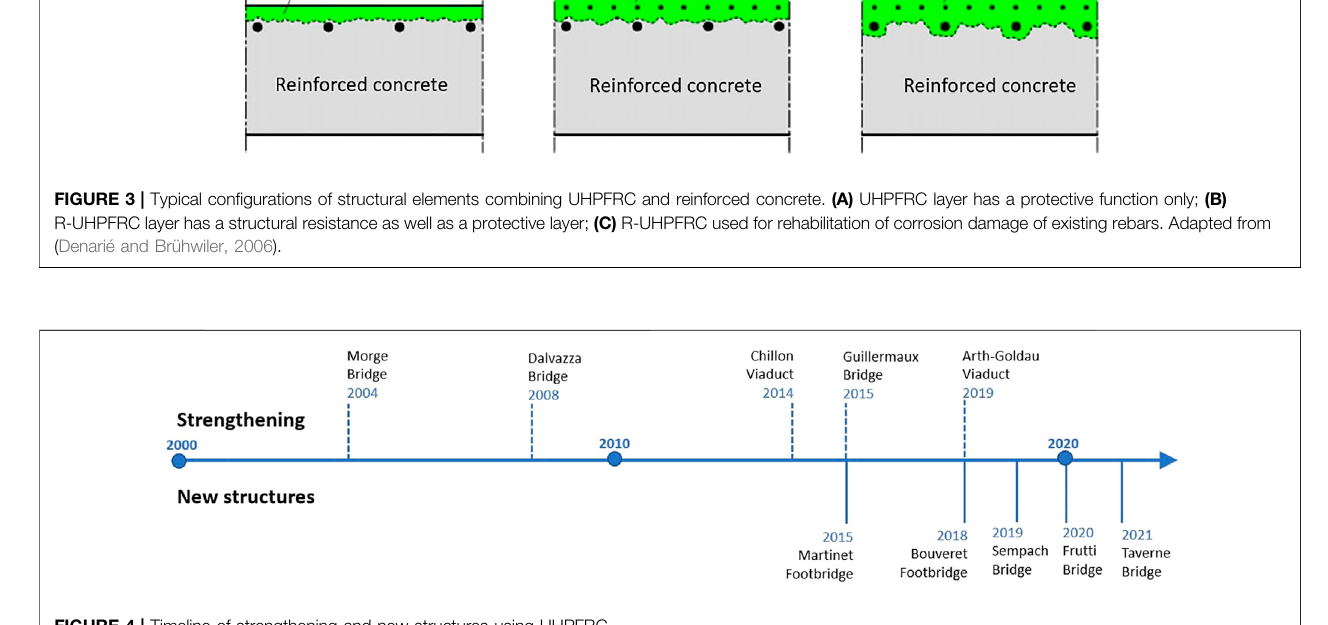
FIGURE 4 | Timeline of strengthening and new structures using